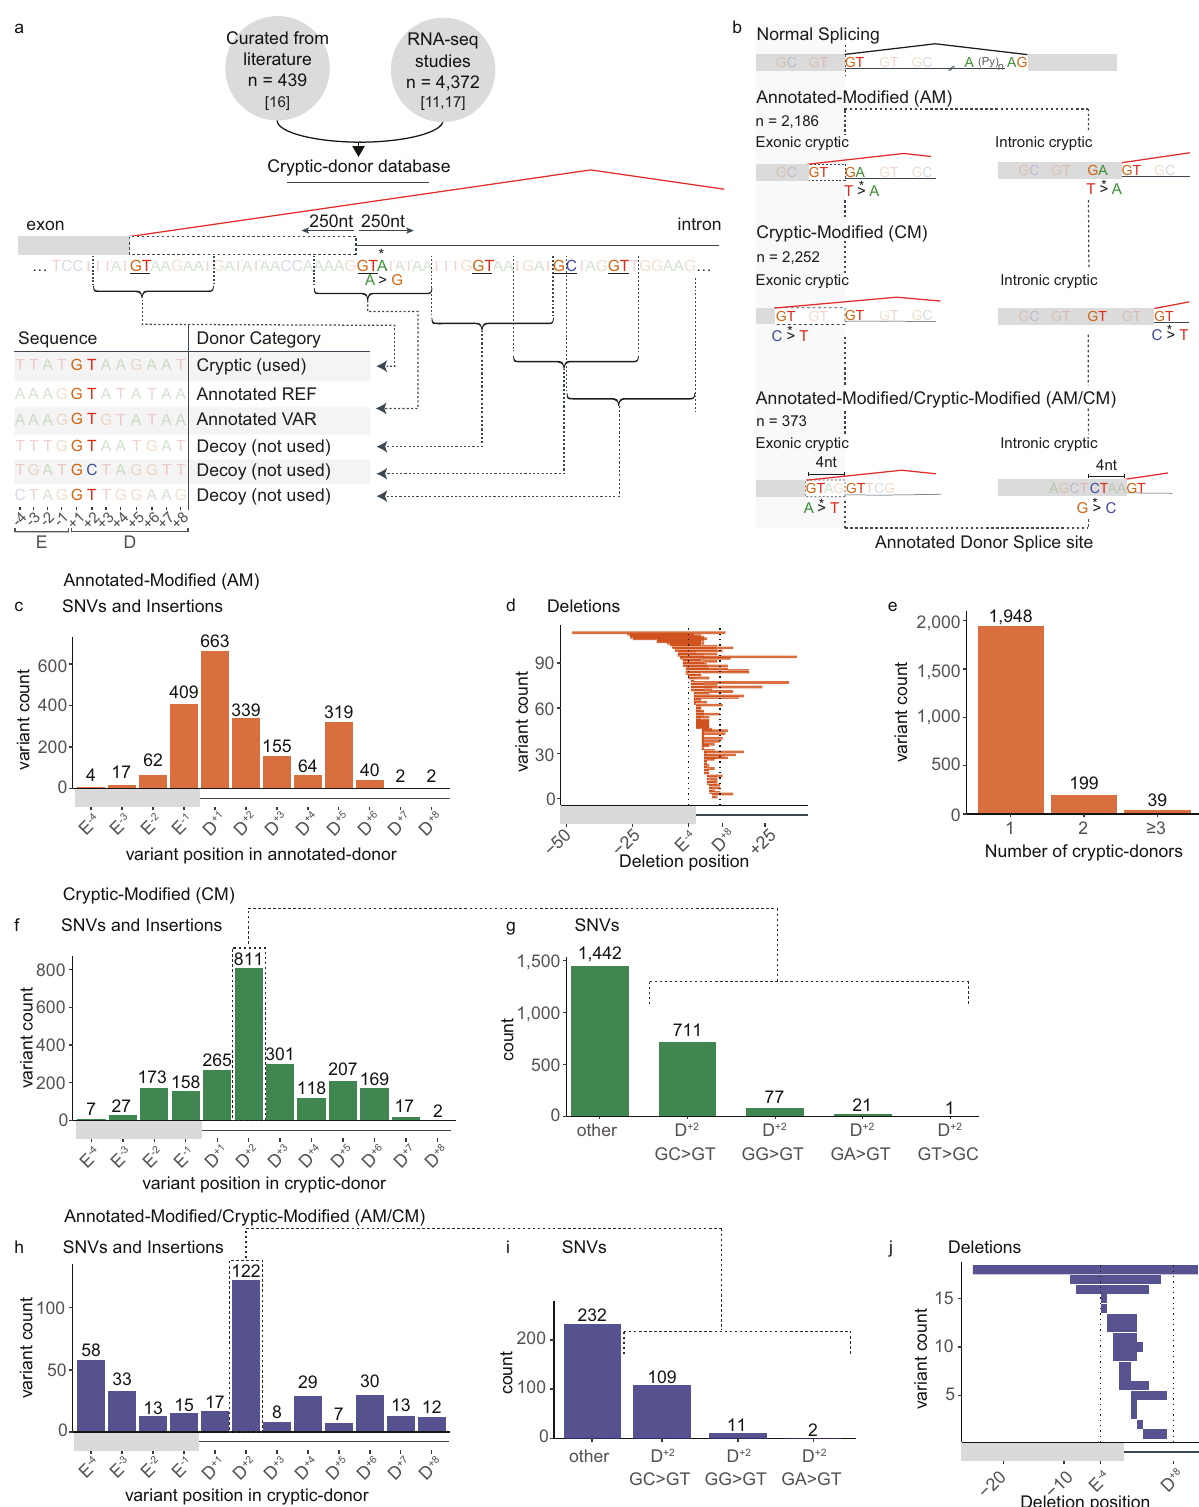
Fig. 1 Reference database of variants activating a cryptic-donor. a Schematic of the cryptic-donor database. E = Exon, D = Donor. See methods. b Three categories of cryptic-donor variants in the database: Annotated-Modi fi ed (AM-variants), Cryptic-Modi fi ed (CM-variants) and Annotated-Modi fi ed and Cryptic-Modi fi ed (AM/CM-variants). c – e Characteristics of AM-variants ( n = 2186, orange). Positions of AM ( c ) Single Nucleotide Variants (SNVs), insertions and ( d ) deletions relative to the annotated-donor. In ( d ) each of the horizontal bars represents one deletion variant showing the position and width of each deletion relative to the annotated-donor. e The number of cryptic-donors activated by each AM-variant. f – g Characteristics of CM-variants ( n = 2255; green). f Positions of CM SNVs and insertions relative to the cryptic-donor. g Frequency of SNVs resulting in cryptic activation, highlighting the prevalence or GC > GT D + 2 variants. h – j Characteristics of AM/CM-variants ( n = 373, blue). h , i As in f , g . j As in d .